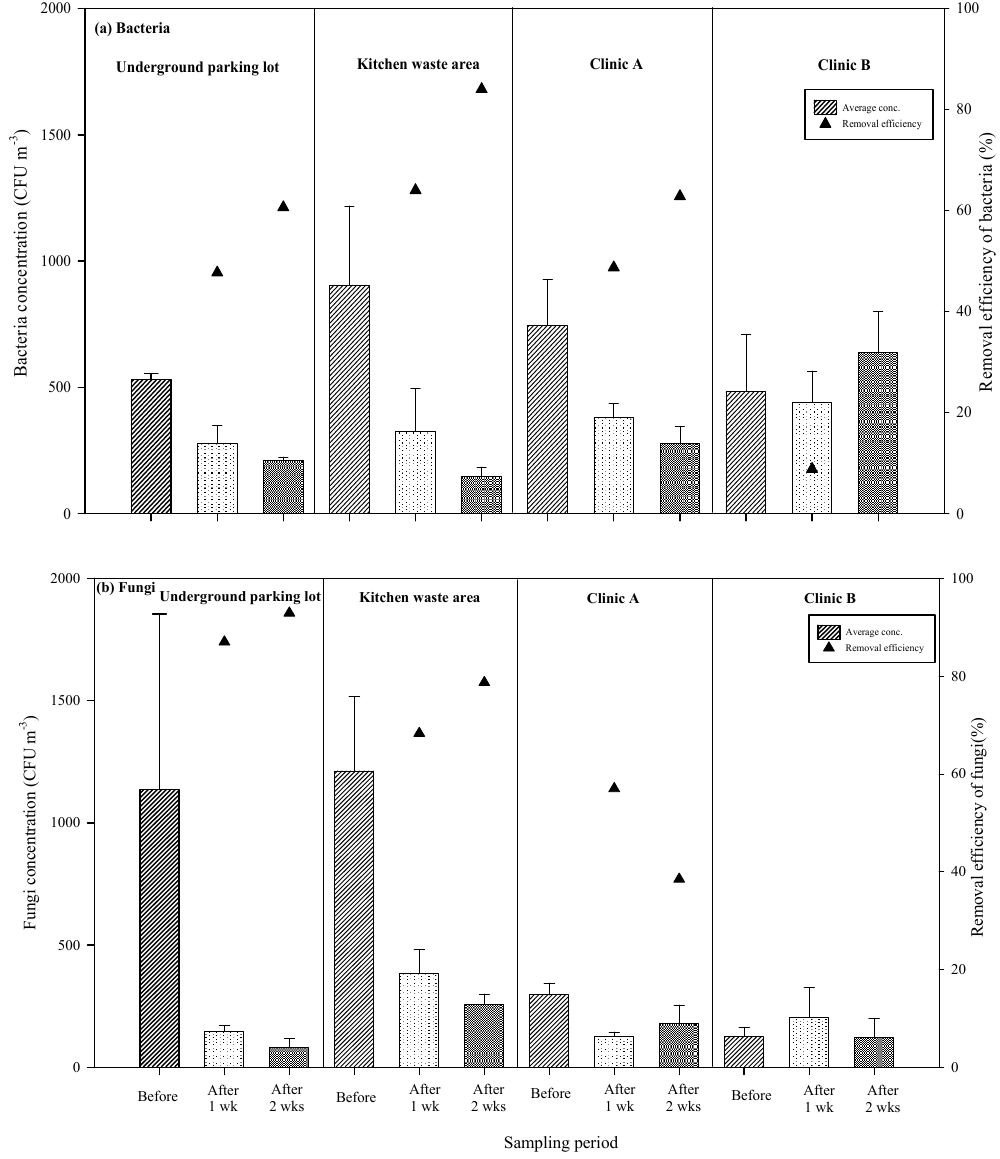
Figure 5. E ffi ciency of microbiological air pollutants: ( a ) Bacteria and ( b ) fungi removal by long-term UVGI exposure.